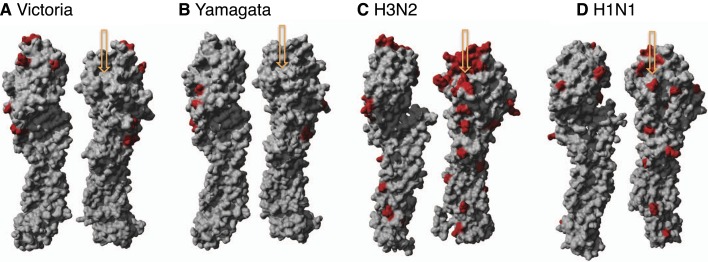
Structural view of mutational drift in influenza A and B
viruses.Amino acid mutations accumulated over 10 years (red) using different
rotations of the hemagglutinin monomer structure of influenza B Victoria
(2002–2012) (PDB:4FQM) (A), Yamagata
(2002–2012) (PDB:4FQM) (B) in comparison to seasonal
influenza A H3N2 (1999–2009) (PDB:2YP4) (C), and H1N1
(1997–2007) (PDB:3UBE) (D) viruses. Arrows point to
receptor binding pocket.